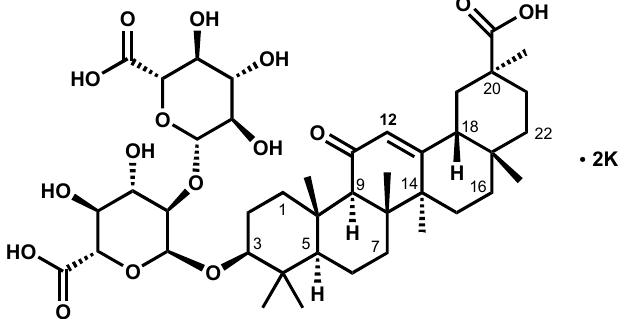
Figure 1. Structure of dipotassium glycyrrhizinate (KG).